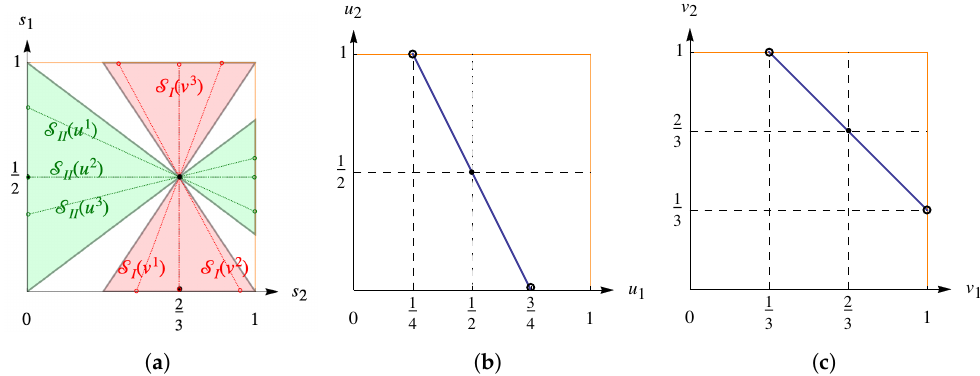
) , plot ( a ) shows the range of all possible Figure 3. For stationary distribution ( s 1 , s 2 ) = ( 1 , 2 2 3 attainable sets generating it. Namely, the green region (the red region) is a ‘combination’ of all possible attainable sets of player 2 (player 1), which are lines similar to Figure 2a (to Figure 2b). Notice that all profiles ( u i , v j ) result in the same stationary distribution but different attainable sets S ( v j ) , S ( u i ) ; here u 2 = ( 1 ) , v 3 = ( 2 ) are unconditional RSs. Plots ( b , c ) depict all SRSs , 1 , 2 I II 2 2 3 3